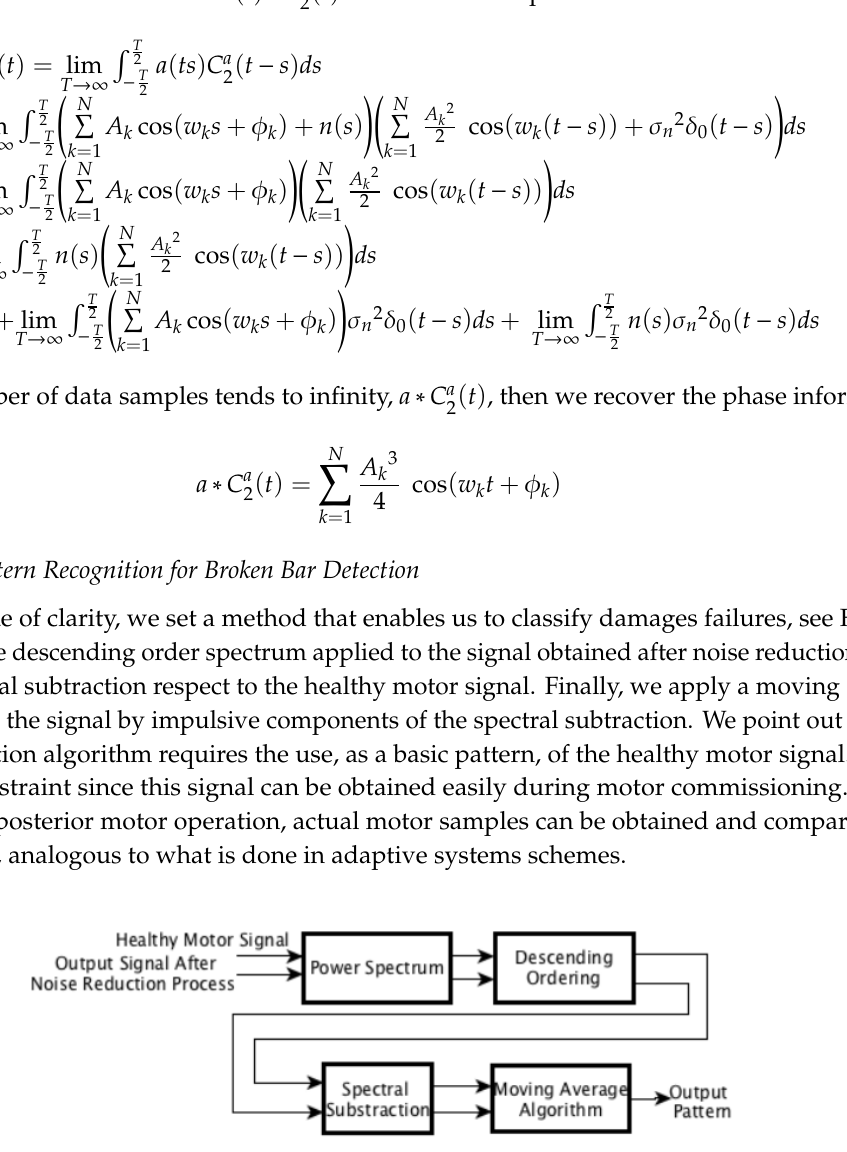
Figure 3. Block diagram of the spectral pattern recognition algorithm for identifying broken bars.